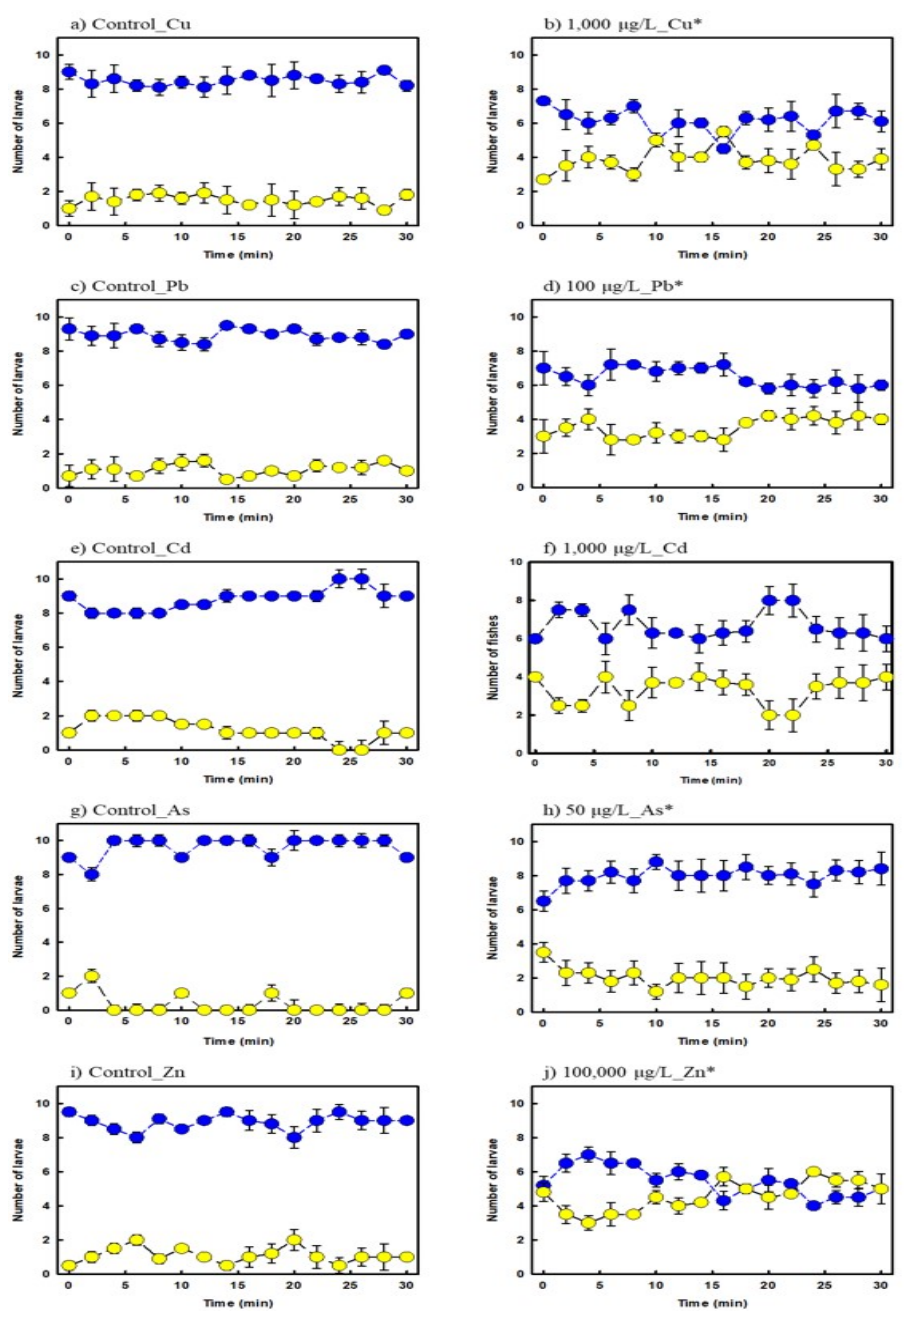
Figure 3. Cognitive function changes of zebrafish larvae after heavy-metal exposure (blue; preferred region, yellow; non-preferred region, * p <